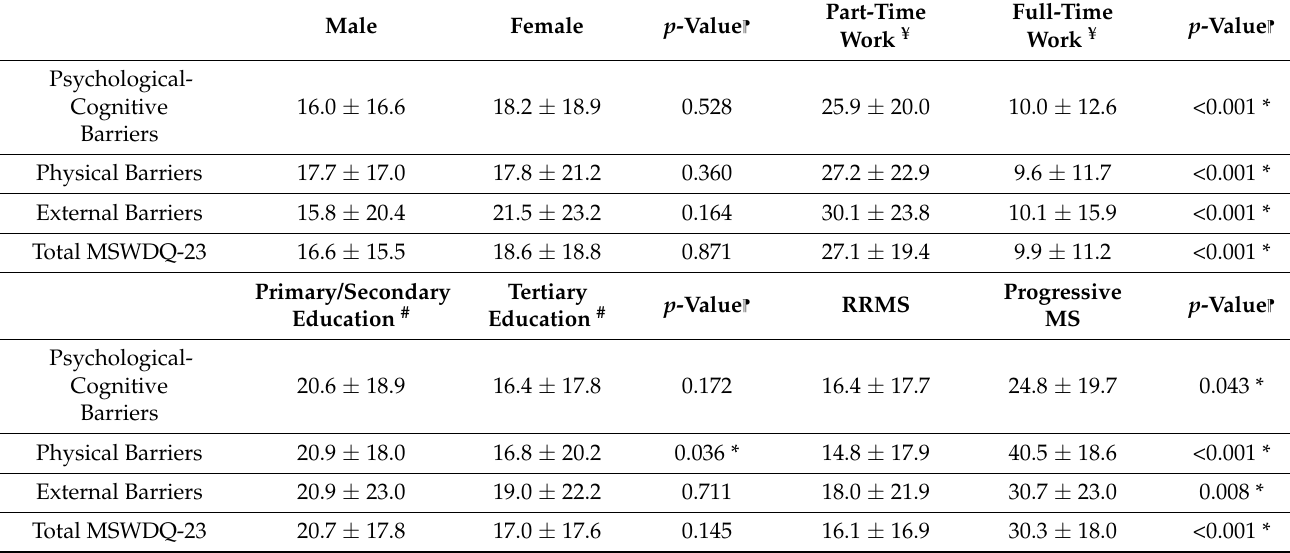
Table 2. Differences in MSWDQ-23 scores between patient groups. Values represent means ± standard deviations.